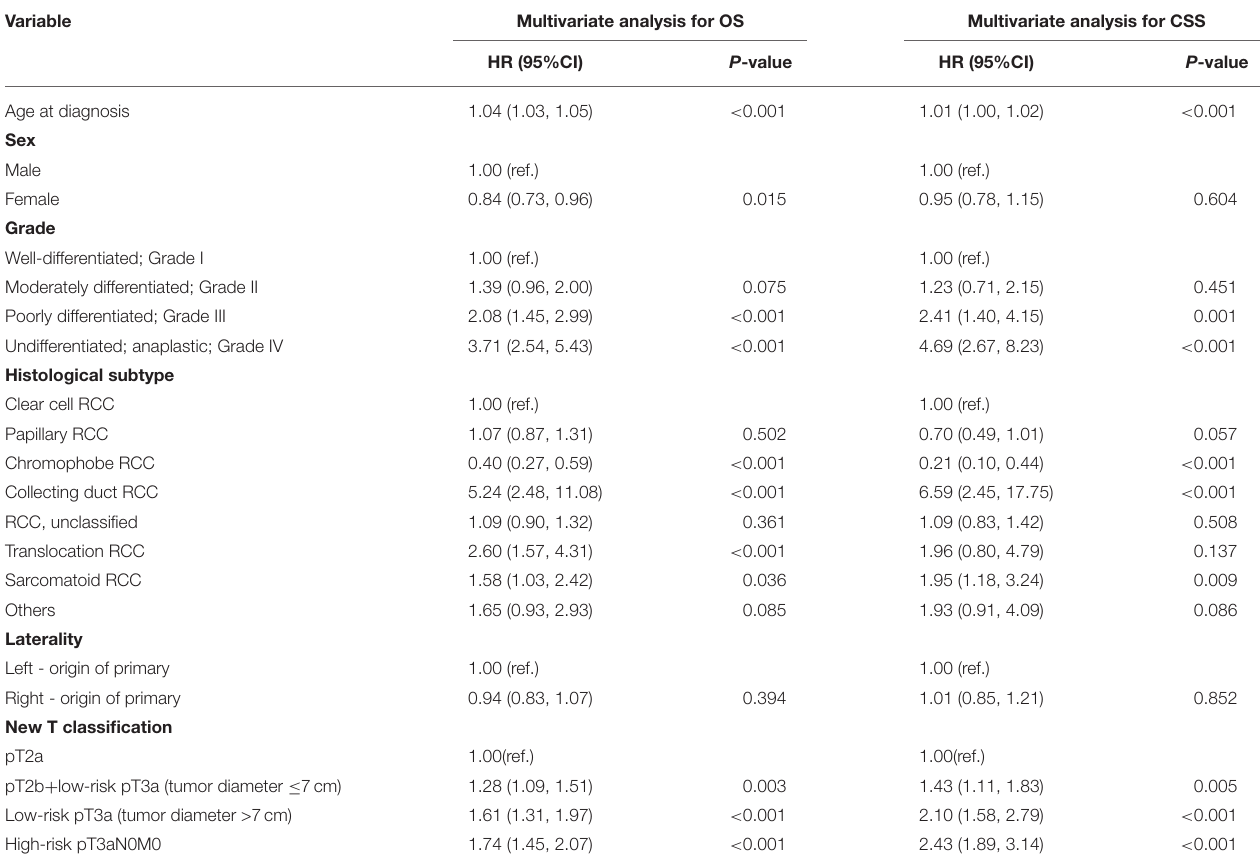
TABLE 3 | Multivariate analyses for overall survival (OS) and cancer-specific survival (CSS). Variable Multivariate analysis for